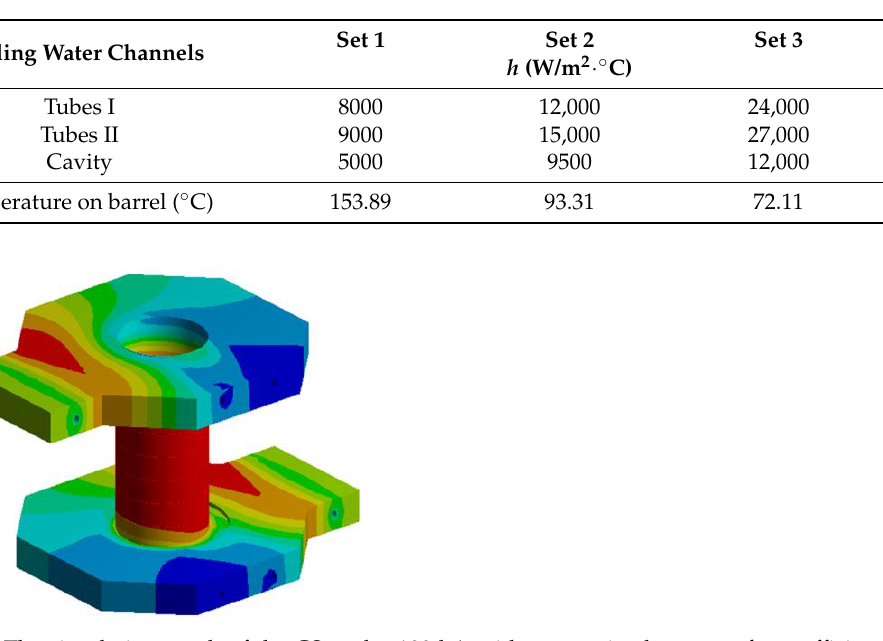
Figure 4. The simulation result of the CS under 100 kA with convective heat transfer coefficient values in Set 3.